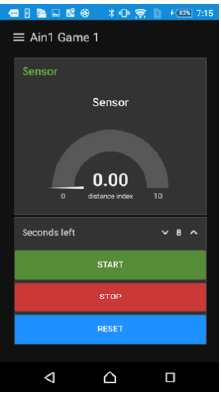
Figure 4. Screenshot of the software for the game prototype.